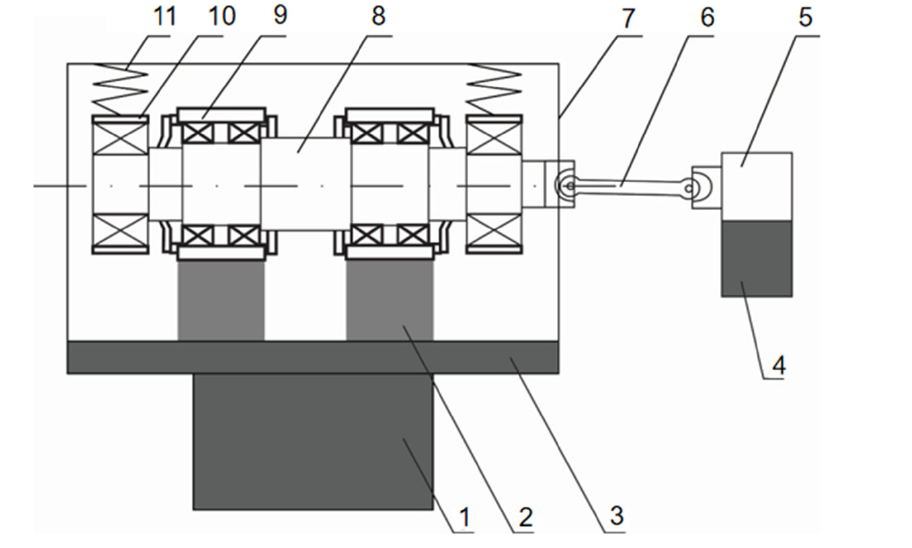
Figure 1. Structure of the bearing system experimental platform.